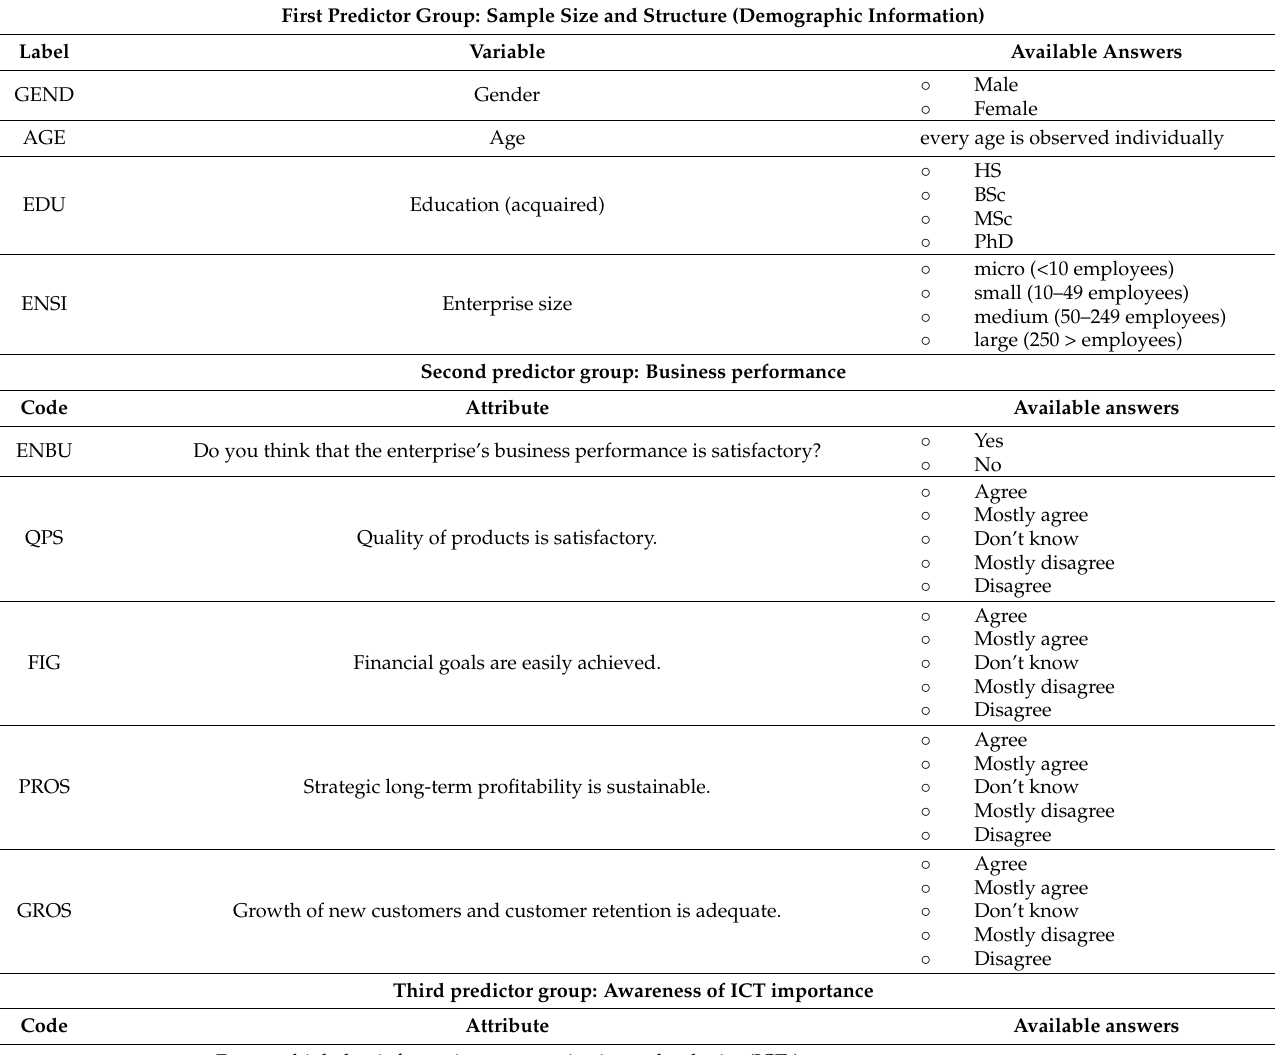
Table A1. Survey, attributes, available answers, and predictor